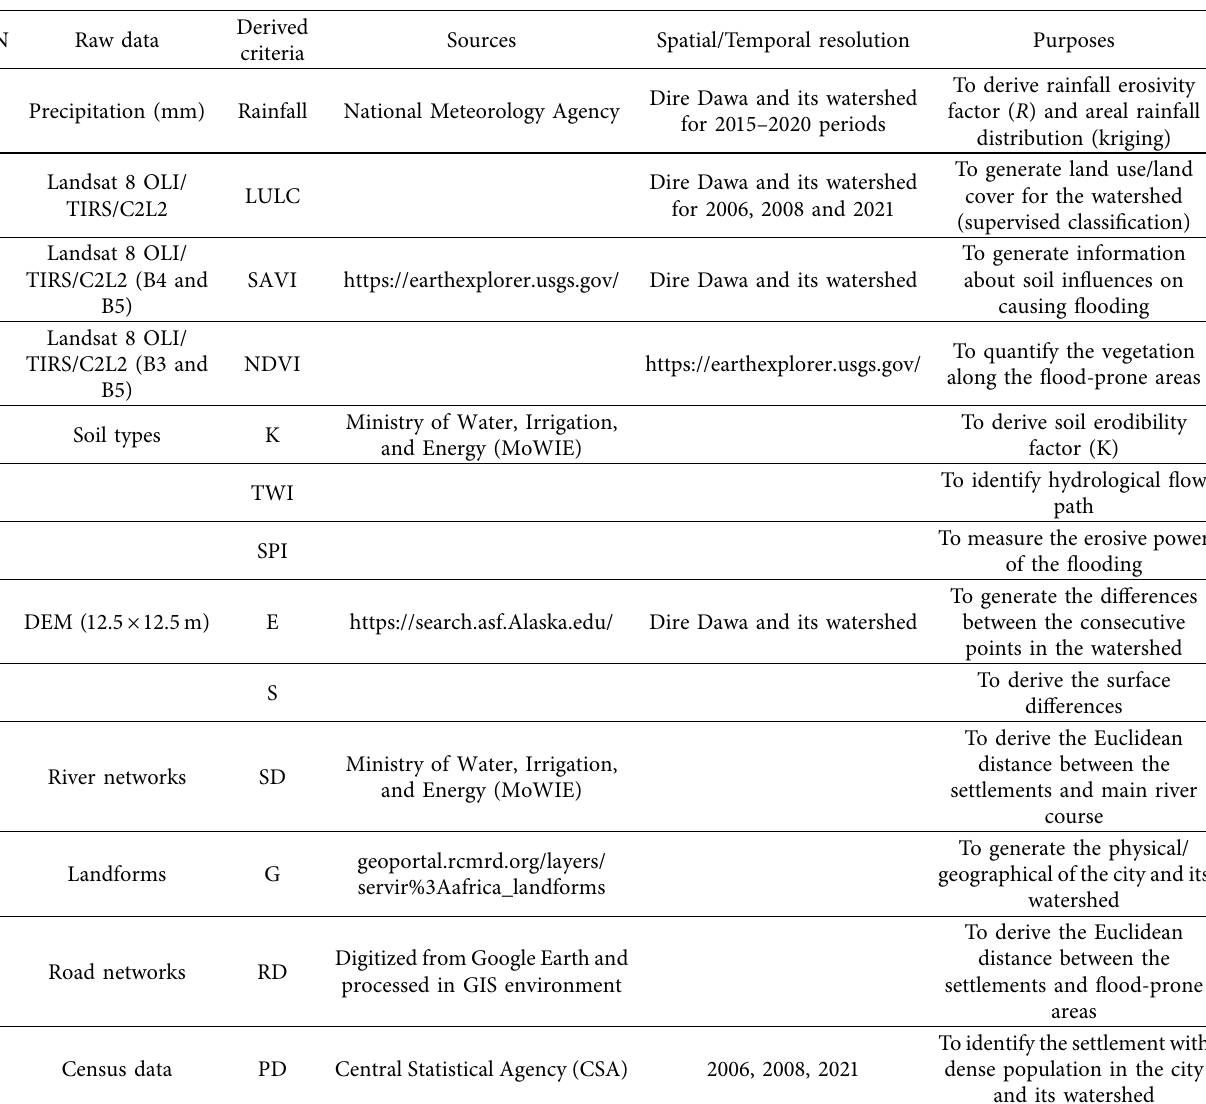
Table 1: Detailed data and sources used in the